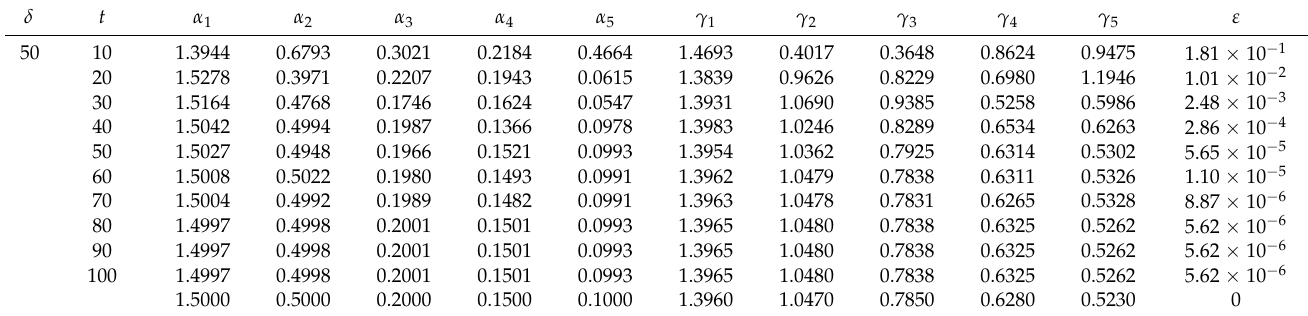
The learning plots of the amplitude and phase parameters estimates, along with the constructed harmonic signal from the estimated parameters, are presented in Figures 5–8 for λ = 0.1, 0.4, 0.7 and 1.0, respectively, for the case of δ = 70 dB, while the respective plots for δ = 200 dB and 50 dB are provided in Supplementary Figures S1–S8, respectively, in the Supplementary Material. The results indicated that the FOPSO correctly estimated the amplitude and phase parameters of the harmonic signal and hence accurately reconstructed the actual signal through the estimated parameters.